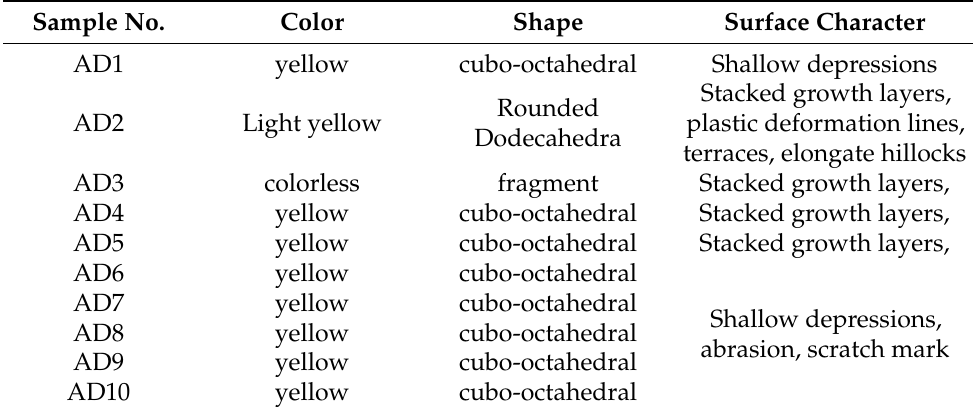
Table 1. Characteristic of the tested Diamonds. Sample